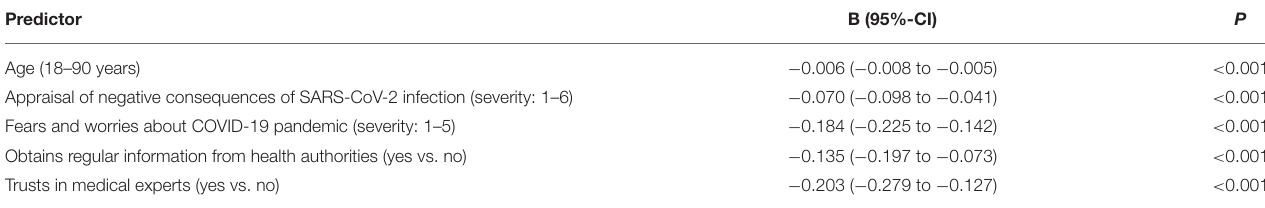
TABLE 3 | Final multivariable prediction model of non-compliance with non-pharmaceutical interventions to mitigate the spread of SARS-CoV-2 ( n = 1,157). Predictor B